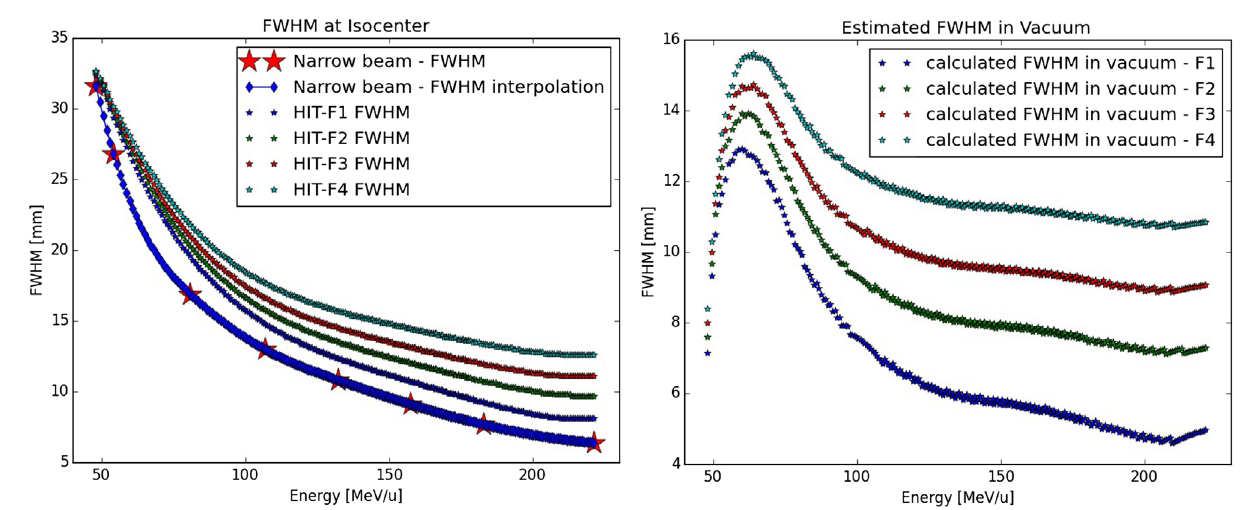
FigUre 3 | calculation of the protons gaussian FWhM in vacuum: on the left panel, the different FWhM size of the proton foci at isocenter from the liBc are displayed as a function of the energy, as well as the calculated FWhM size for the narrow-beam approach (star) and its interpolation; on the right panel, the results of the quadratic subtraction between the two previous quantities yielding the initial beam size in vacuum for the different foci as function of the energy